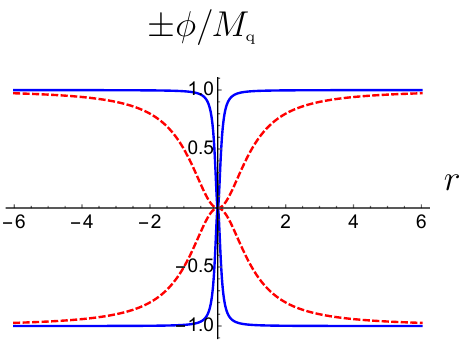
Figure 1 . Brane pro(cid:12)les for (cid:3) = 1 (dashed, red curve) and (cid:3) = 1 = 10 (solid, blue